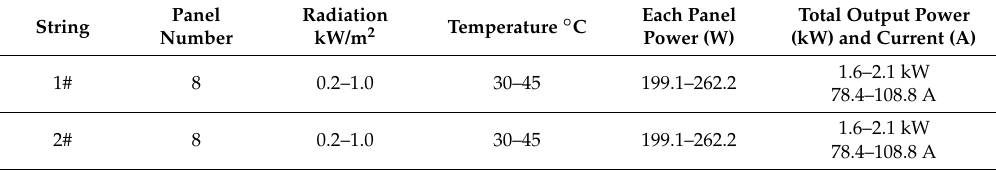
Table 3. Specific parameters of a rooftop PV system with two strings in summer